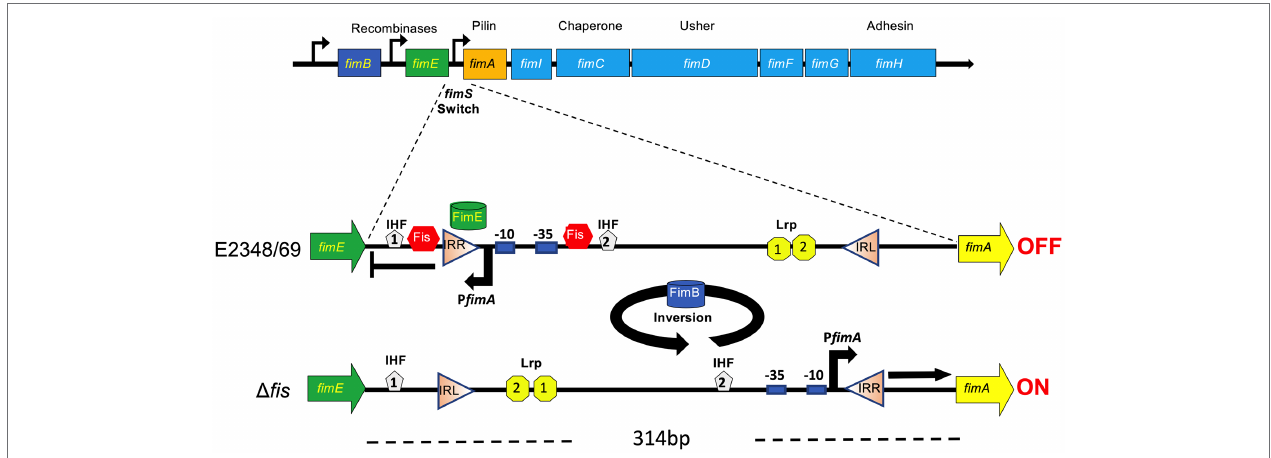
FIGURE 7 | Model for the role of Fis in the site-specific inversion of the fimS switch in EPEC. The orientation of the fimS invertible segment (314 bp long) located between fimE and fimA , is controlled by two recombinases, FimB and FimE. FimE locks the fimS switch in the OFF orientation while FimB inverts the fimS switch in both directions. The fimS switch is flanked by the left and right inverted repeats (IRL and IRR, respectively). In EPEC E2348/69, the inversion of the fimS to the OFF position is mediated by FimE and Fis. Based on the data obtained, we postulate that in the absence of Fis (e.g., ∆ fis mutant), high levels of fimA expression are displayed and that FimE-mediated inversion of the fimS switch to the OFF state requires Fis. The putative binding sites of IHF, Lrp and Fis shown are based on the nucleotide sequence homology of the fimS switch between different Escherichia coli